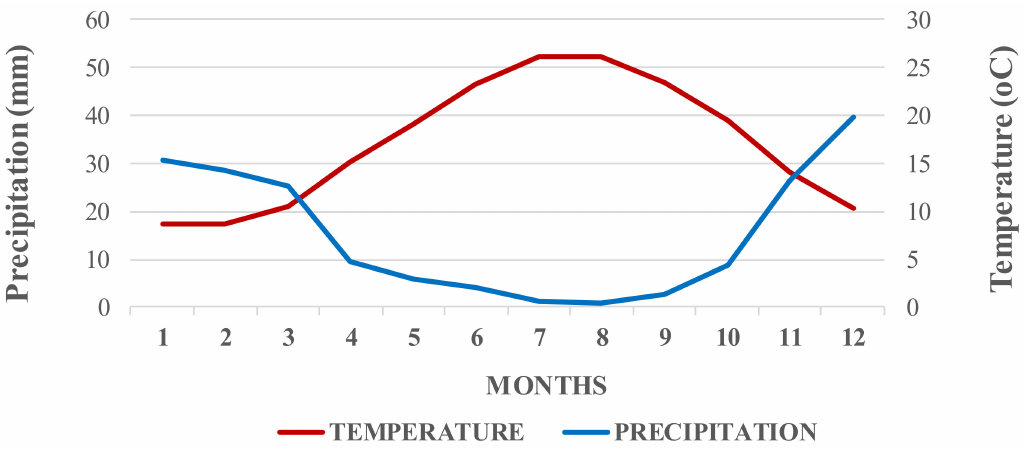
Figure 2. Bagnouls–Gaussen’s ombrothermic diagram of Cyprus (period 1986–2000—average of 10 meteorological stations).